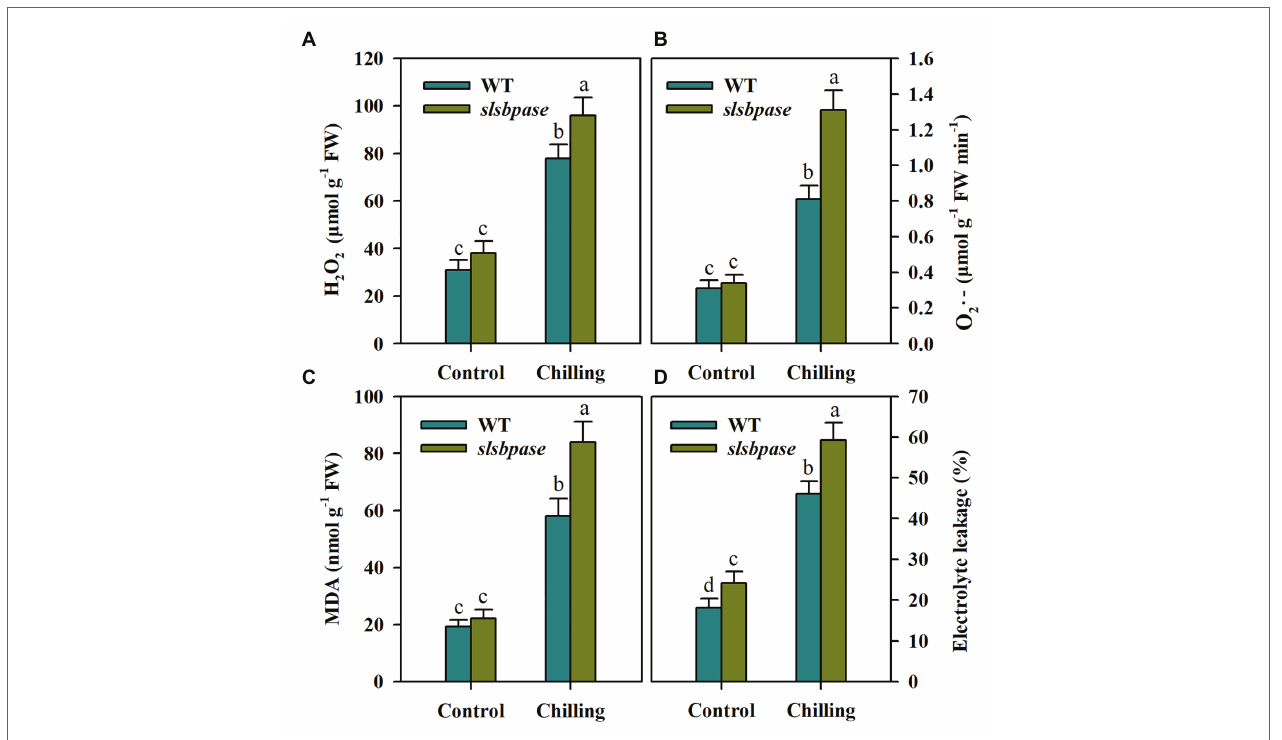
FIGURE 2 | Reactive oxygen species (ROS) accumulation and lipid peroxidation as affected by SlSBPASE mutation in chilling-stressed tomato plants. Lipid peroxidation was assessed by measuring malondialdehyde (MDA) content and electrolyte leakage. (A) H 2 O 2 ; (B) O 2 · − ; (C) MDA content; and (D) electrolyte leakage. At the fourth-leaf stage, slsbpase mutants and wild-type plants were subjected to chilling stress for a period of 24 h. Following that, leaves from different groups were sampled for the quantification of ROS and measurement of lipid peroxidation. The results are presented as mean values ± SDs from three independent experiments, and different letters on top of each column represent significantly different values at p < 0.05 among treatments.